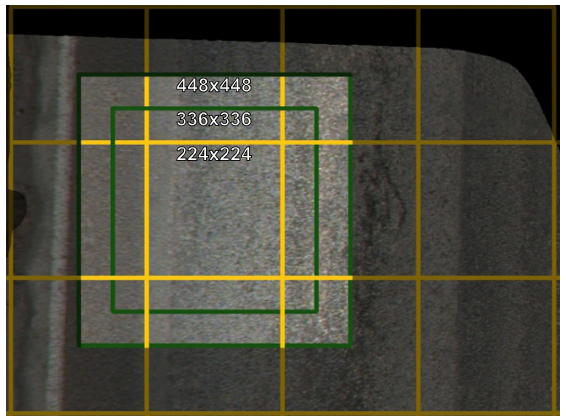
Figure 16. Visualization of the context captured for different DSN patch sizes. For models with input sizes of 336 × 336 or 448 × 448, the output gets cropped to the central part of size 224 × 224. In each case, the orthoframe still gets partitioned into patches of size 224 × 224, which are shown as yellow squares.